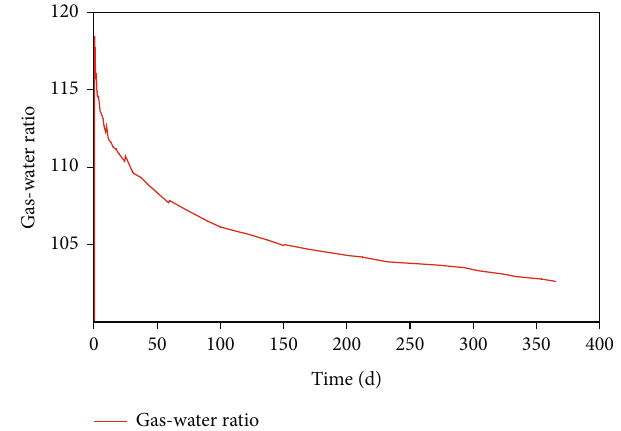
Figure 11: Performance of the gas-water ratio.